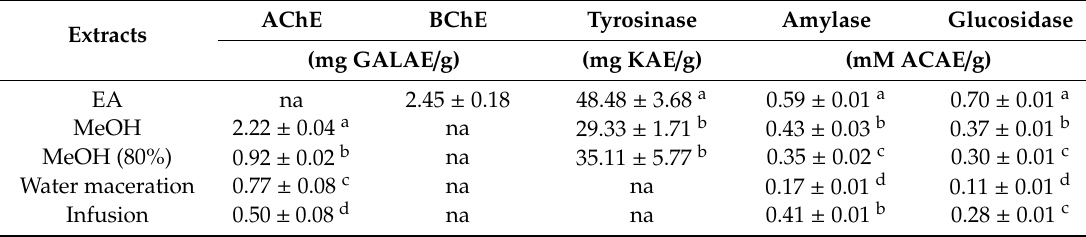
Table 5. Enzyme inhibitory properties of the tested